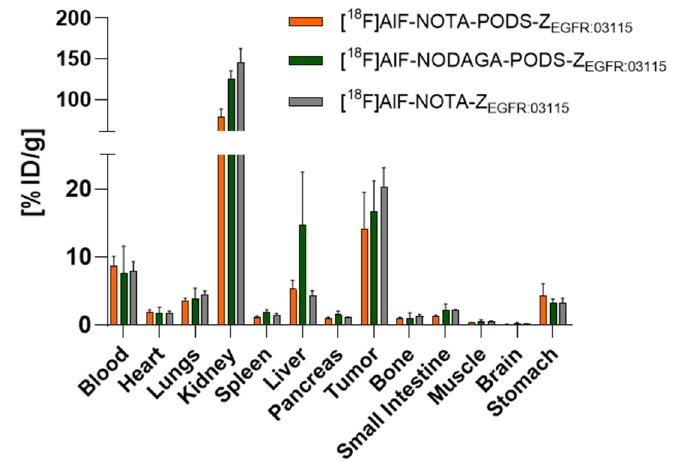
Figure 3. Biodistribution results for [ 18 F]AlF-NOTA-PODS-Z EGFR:03115 and [ 18 F]AlF-NODAGA-PODS-Z EGFR:03115 at 1 h p.i. [ 18 F]AlF-NOTA-Z EGFR:03115 was used as a control. The data are reported as the mean percentage of the injected dose per gram of tissue (%ID/g) ± SD (for each group, n = 3).